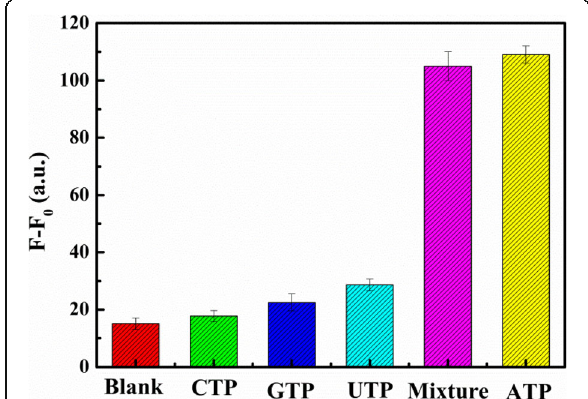
Fig. 7 The selectivity: ATP, UTP, CTP, and GTP were 510 nM